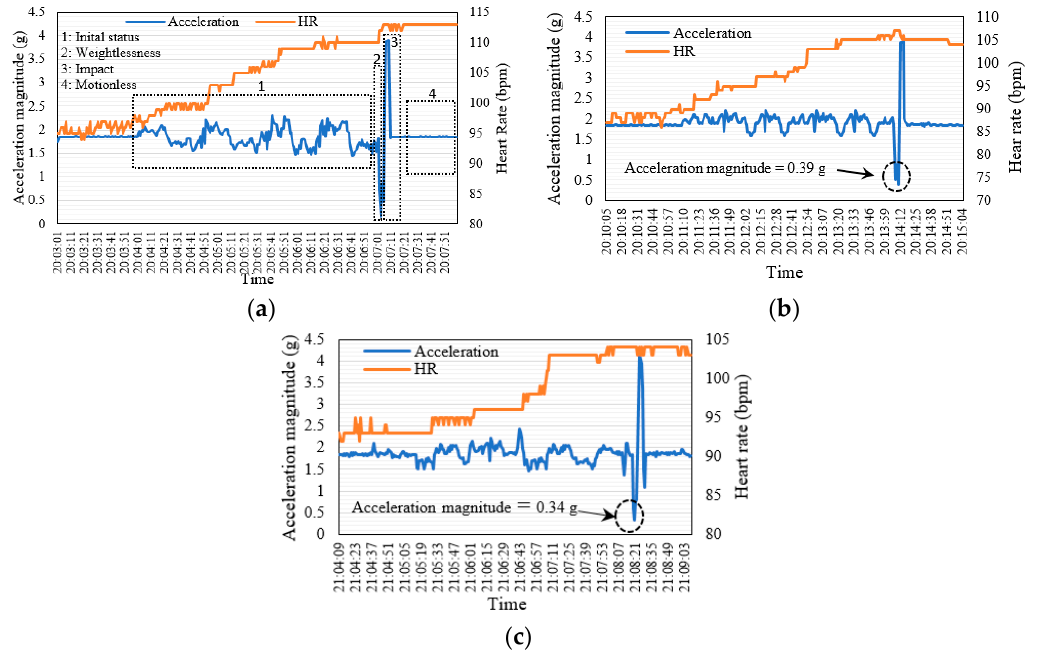
Measurements of the FDB-HRT algorithm for three volunteers: ( a ) 28, ( b ) 30, and ( c ) 31 years old.